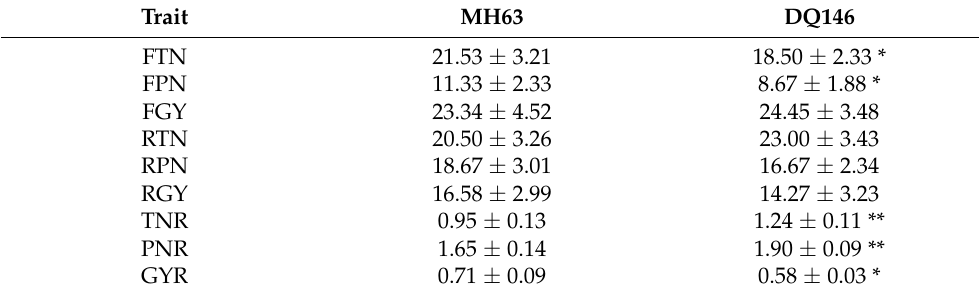
Table 4. Comparison of ratooning-ability-related traits between DQ146 and Minghui 63. Trait